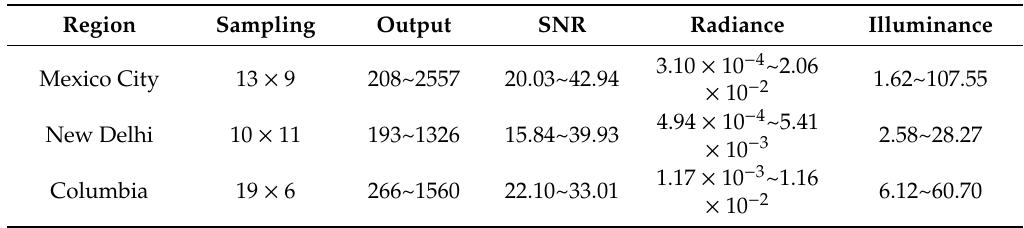
Table 6. Statistics data of the on-orbit SNR